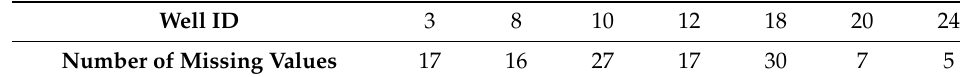
Table 2. Number of missing values for wells with missing data.